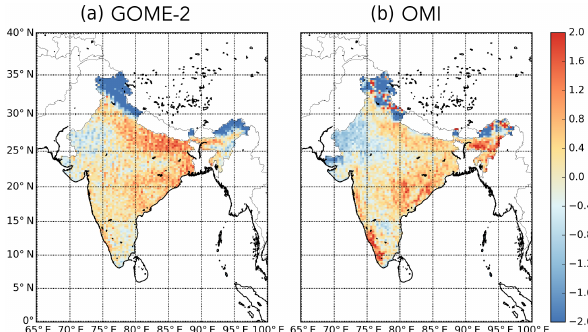
Figure 13. Standardized HCHO slant columns for 2014 (unitless) from (a) the Global Ozone Monitoring Experiment-2 (GOME- 2) aboard MetOp and (b) OMI, averaged on a common 0 . 25 ◦ × 0 . 3125 ◦ grid. GOME-2 and OMI have local equatorial overpass times of 09:30 and 13:30,